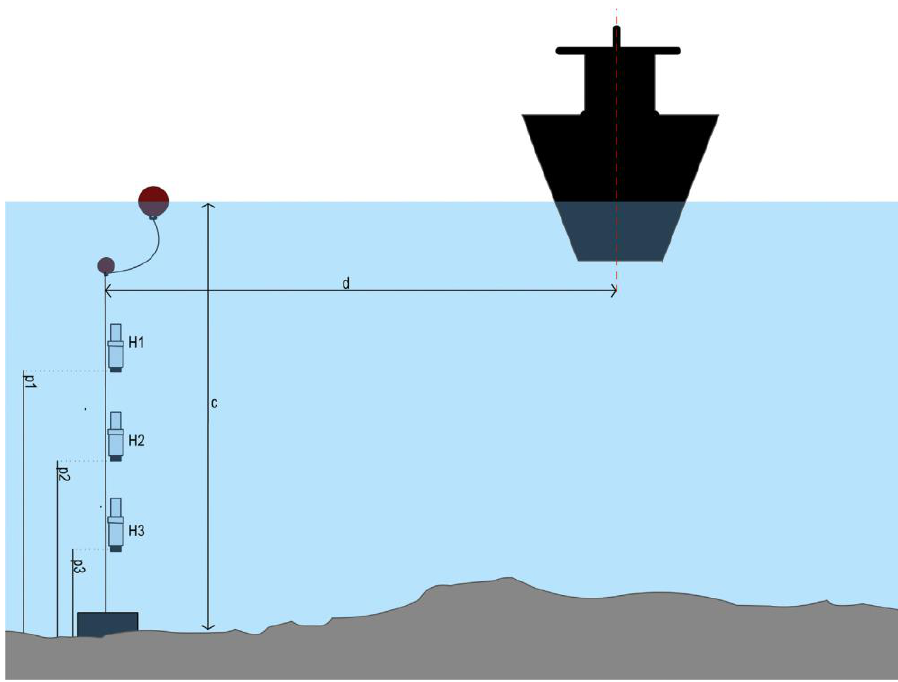
Figure 10. ShipsEar data collection diagram.